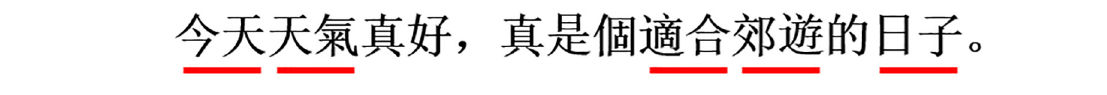
graders (10 males, mean age = 15.25 years, ranging from